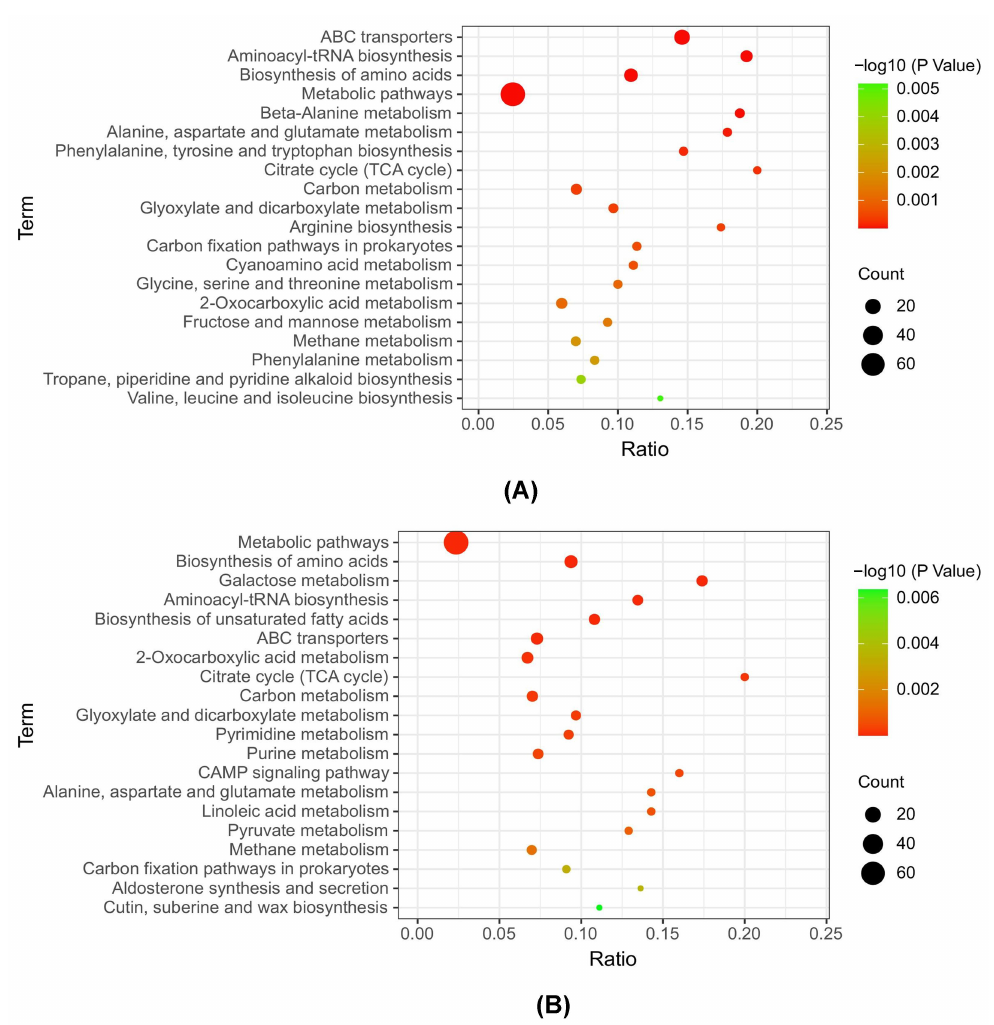
Figure 5. Enrichment of Kyoto Encyclopedia of Genes and Genomes (KEGG) pathway analysis in different metabolic pathways in leaves ( A ) and stems ( B ) of ginseng induced by P. cactorum .